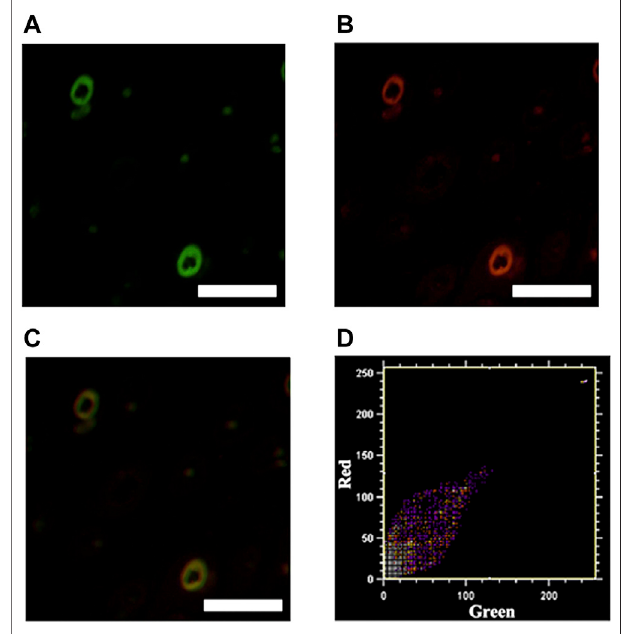
FIGURE 4 | Mouse tissue sections stained with ICG@HMONs-HA (A) and LYVE-1 antibody (B) , and merged image (C) . Scale bars equal 200 μ m. (D) Co-localization analysis using Co-localization Finder plugins in Fiji ImageJ